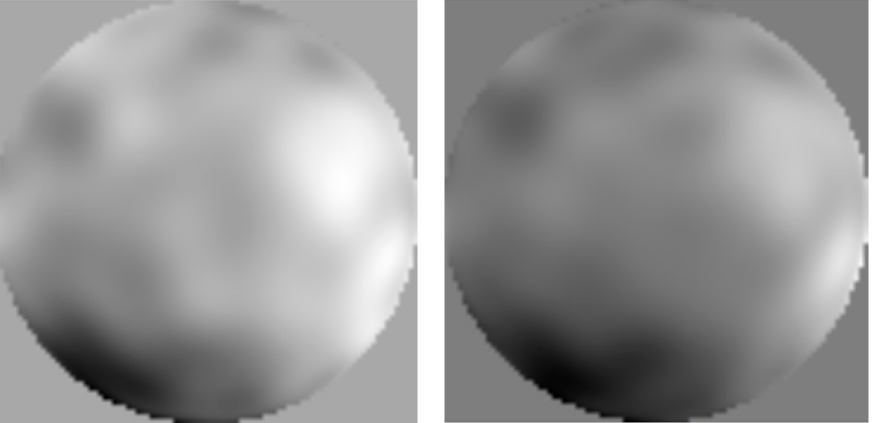
Figure 4. Comparison for r 0 = 12 cm. The residual WFE for this case is 110.45 nm, lower than the mean value obtained over the test. The original phase is placed on the left, with the reconstructed one shown on the right.